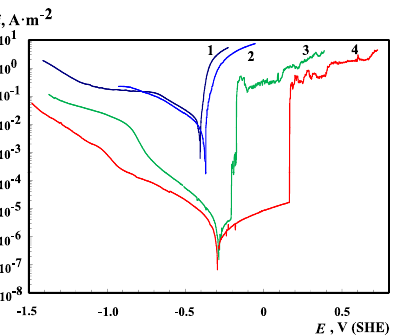
Figure 3. Polarization curves of 6063 alloy in a borate buffer solution (pH 7.4) containing 1 mmol·L − 1 NaCl, after LP-2 and SHP treatment in the solutions of CI ( C , mmol·L − 1 ): 1 —without treatment; 2 —after LP-2; 3 —10 SA; 4 —1 ODPA.